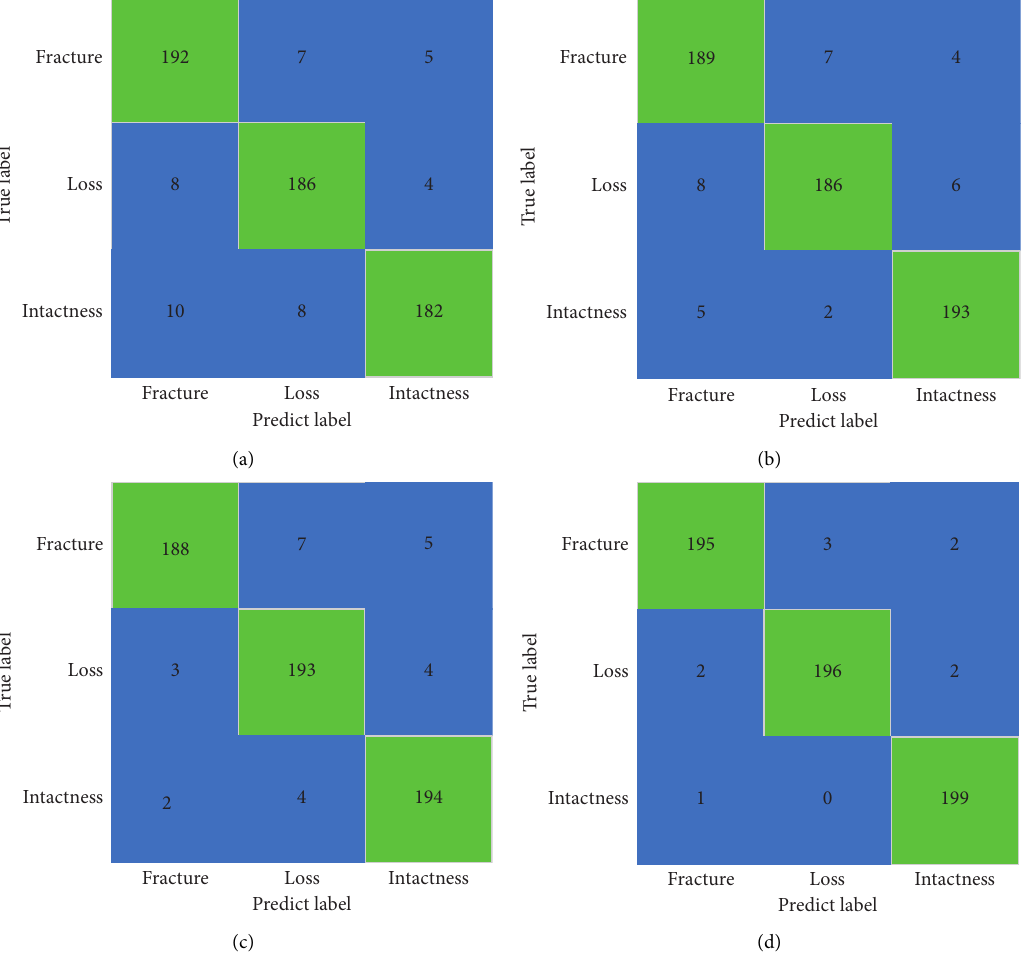
Figure 16: Visualization of data set classification results. (a) LBP +SVM, (b) HOG +SVM, (c) VGG16, and (d)